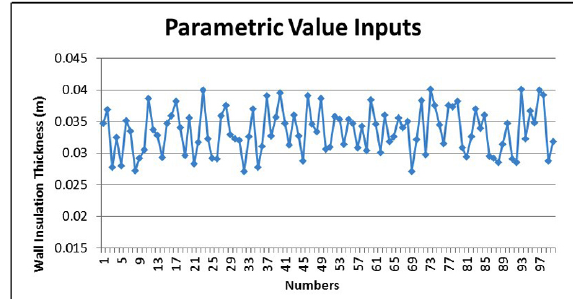
Fig. 8. Input samples of wall insulation thickness